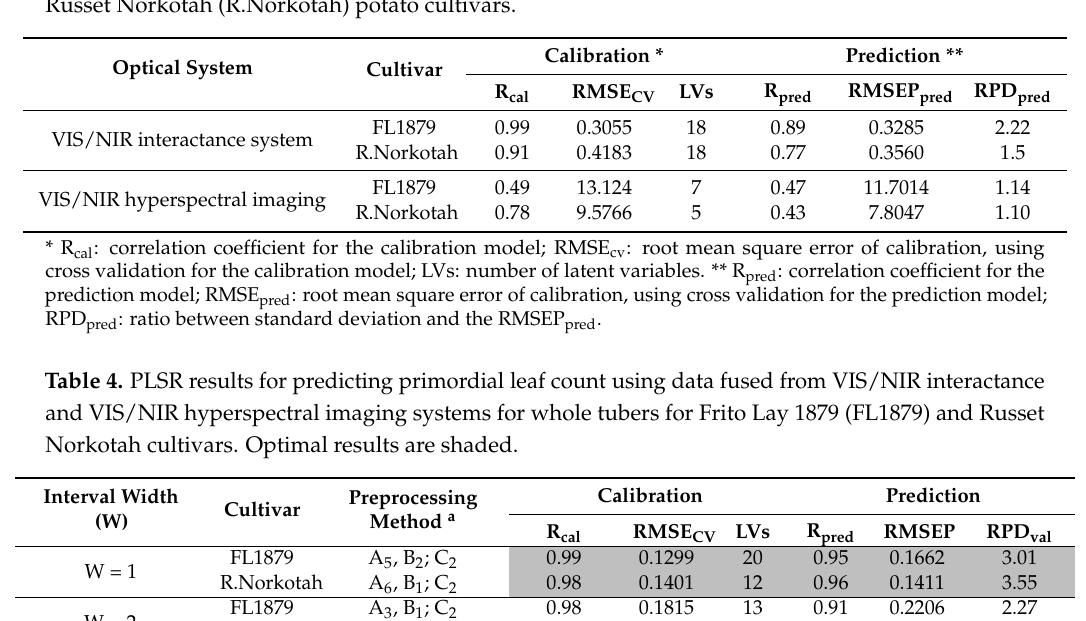
Table 3. Partial least squares regression (PLSR) results of the primordial leaf count, using data obtained from either VIS/NIR interactance or hyperspectral imaging systems for Frito Lay 1879 (FL1879) and Russet Norkotah (R.Norkotah) potato cultivars.